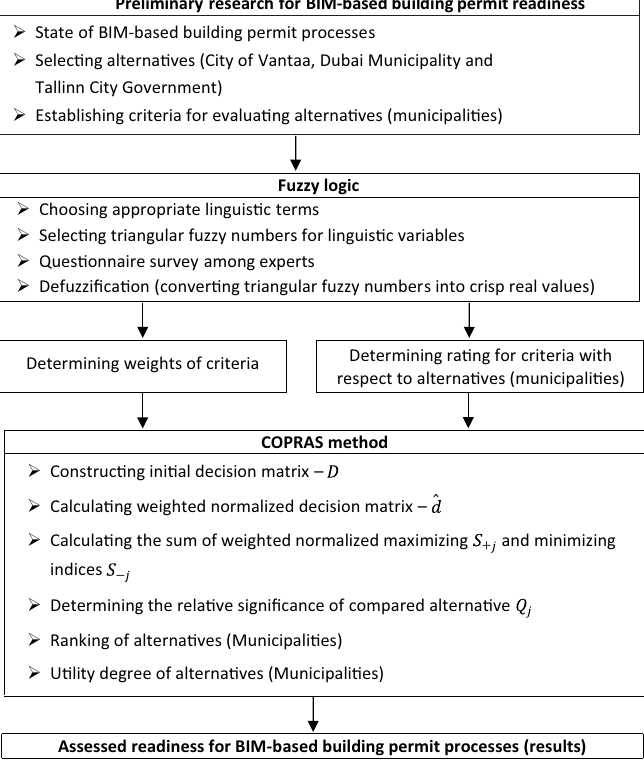
Figure 1. Methodology flow